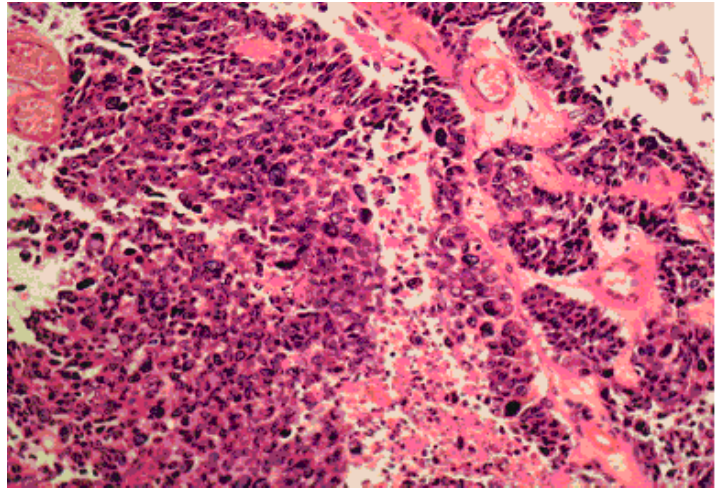
Tumour recurrence and progression rates have been shown to be higher in patients with high-grade tumours or tumours with lamina propria invasion[2]. Initial reports indicate that patients with urothelial TCC at high risk of relapse after radical surgery can have a reasonable chance of long-term survival